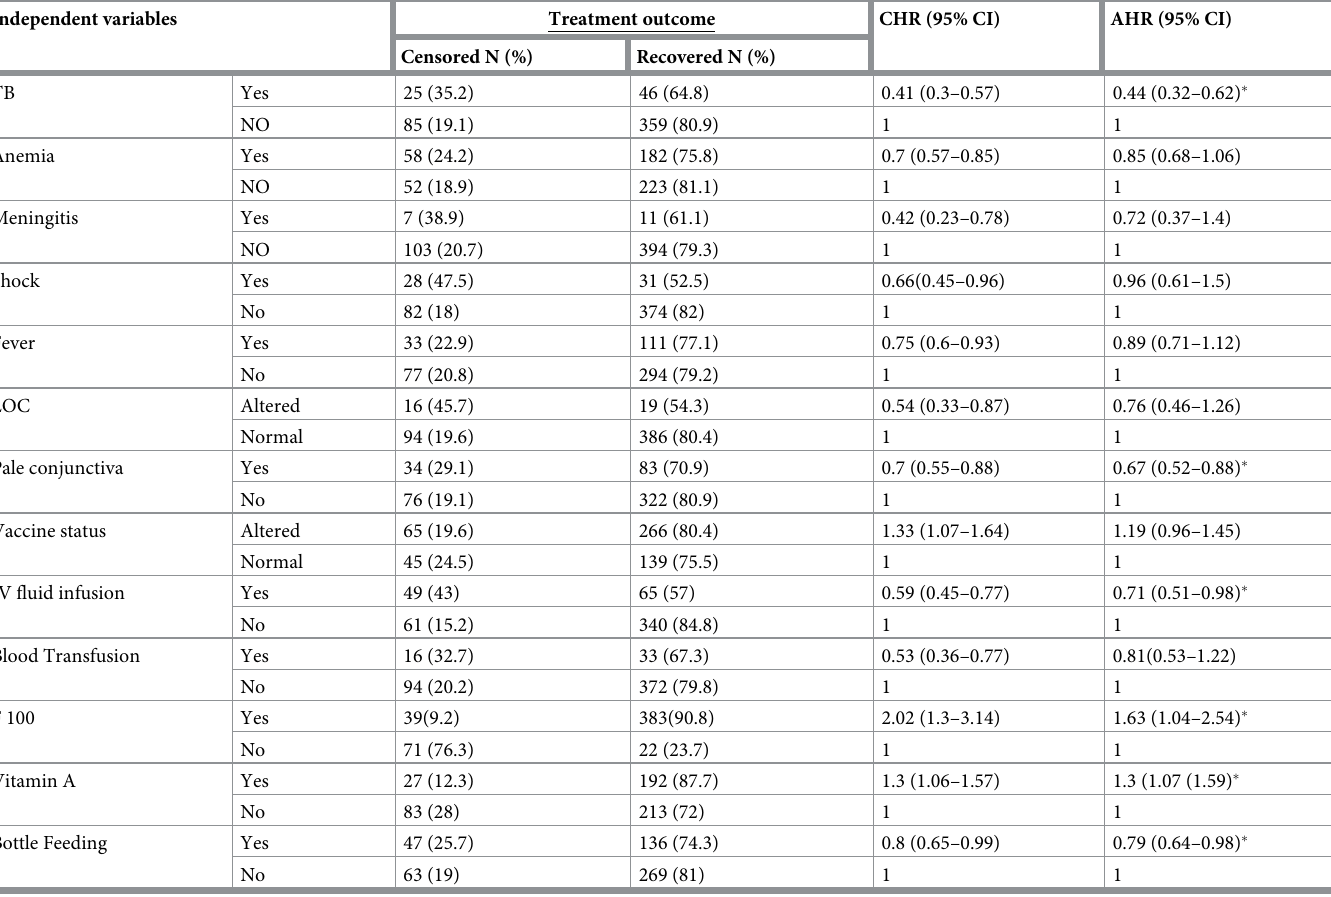
Table 4. Bi-variable and multivariable Cox regression model showing the distribution of factors associated with time to recovery in severely malnourished children admitted to SC of SPHMMC from 2012–2019 (N = 515). Independent